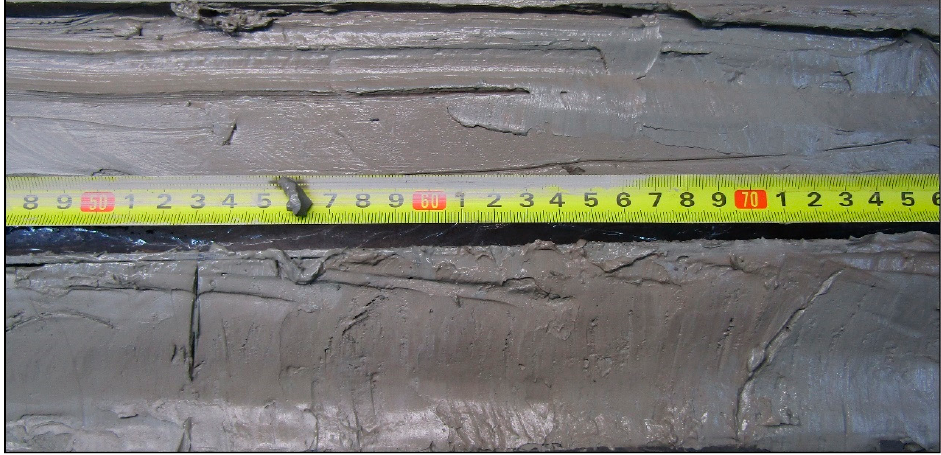
Figure 6. Limno-glacial sediments. Typical thin-laminated varved clays. Lithological unit 3, core ONG-5.